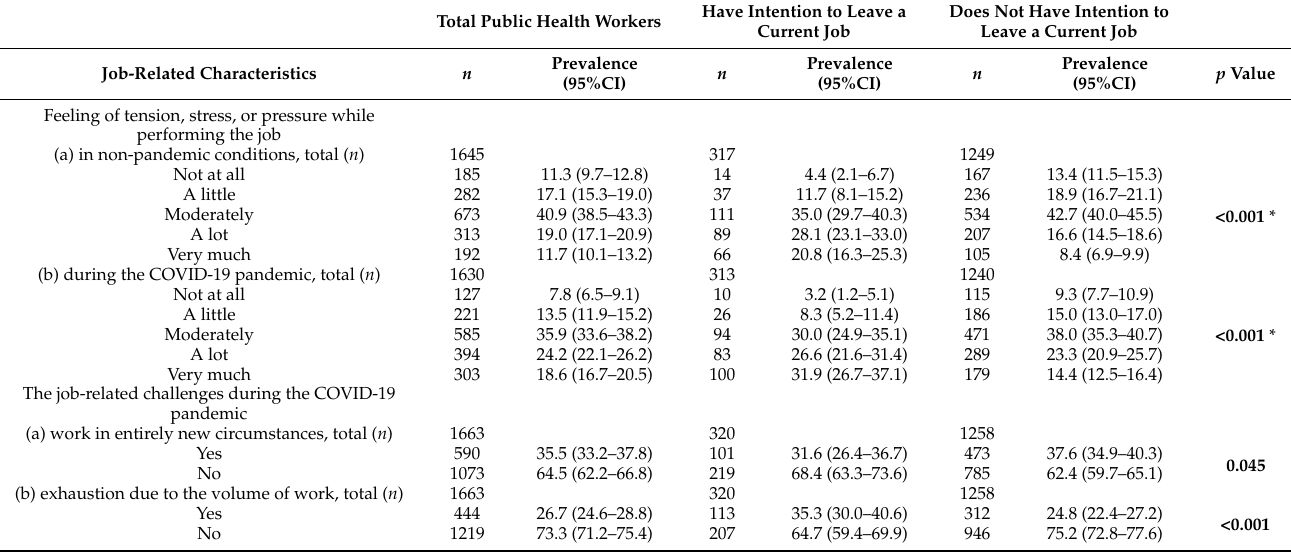
Table 2. Job-related characteristics of public health workers from 25 public health institutes ( n = 1663), according to their intention to leave a current job within the next five years, Serbia,